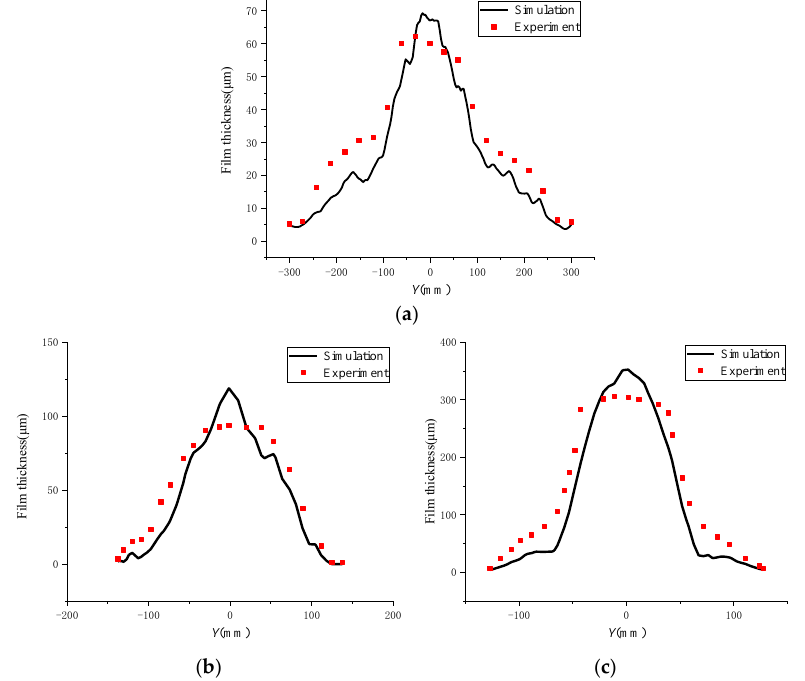
Figure 21. Dynamic spraying film thickness. ( a ) Plane spraying. ( b ) Outer surface translation spraying. ( c ) Inner surface translation spraying.